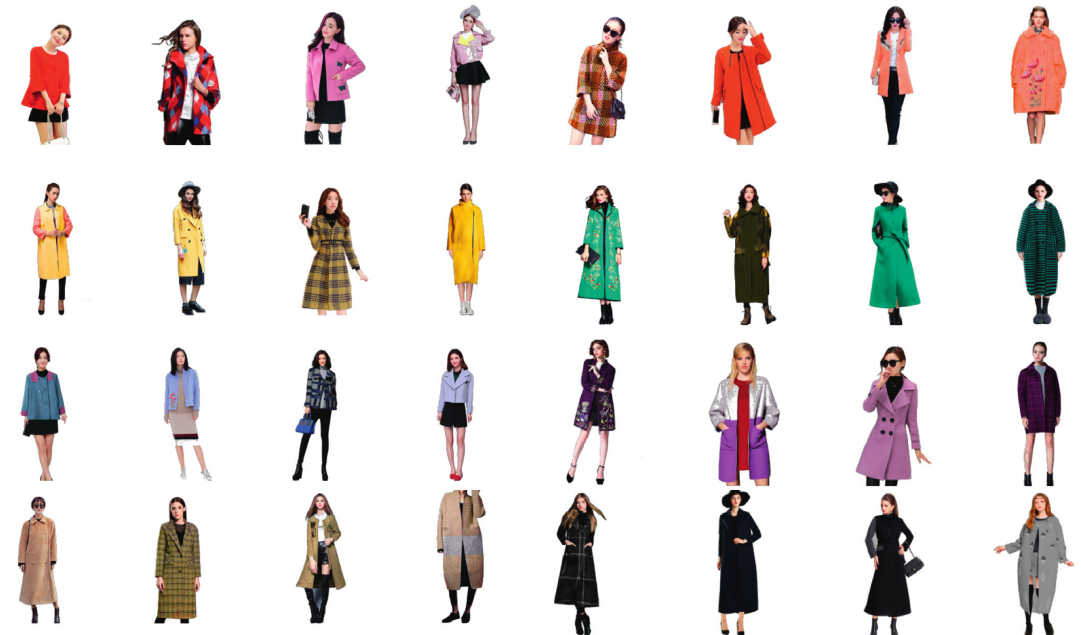
Figure 5: Training images.